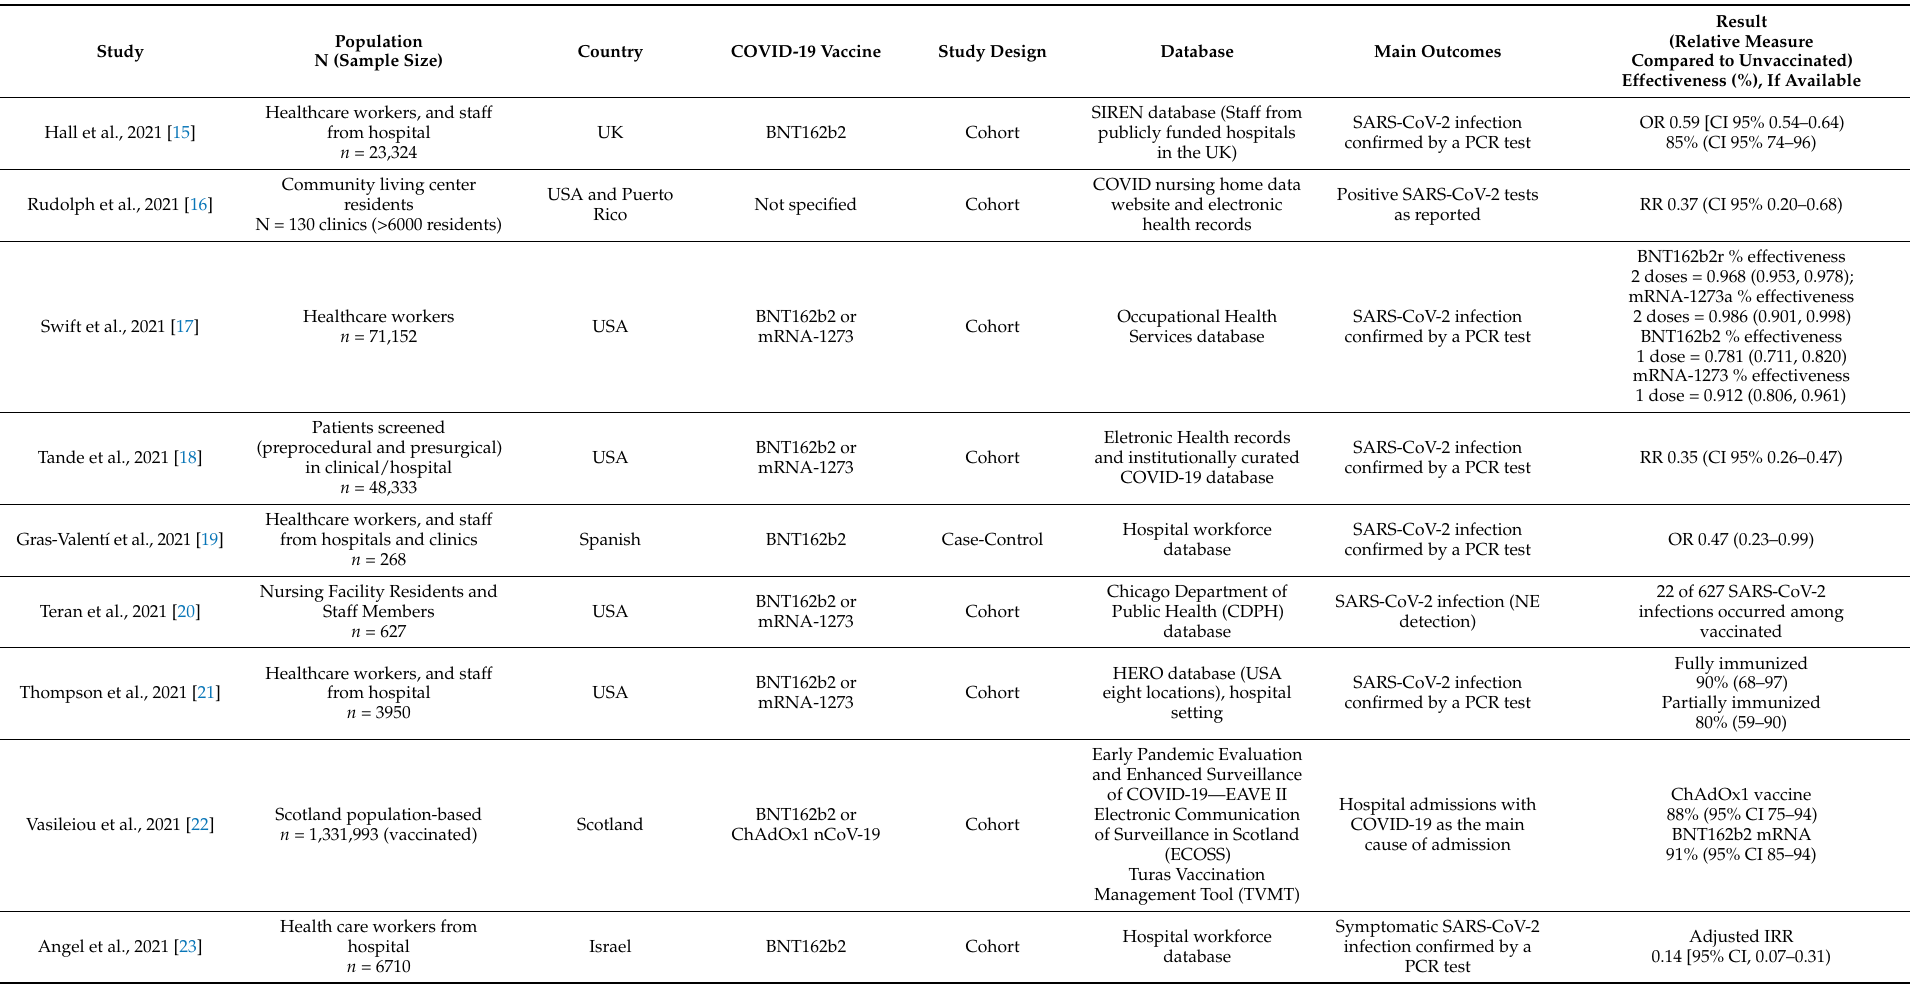
Table 2. Characteristics of studies included assessing the effectiveness of COVID-19